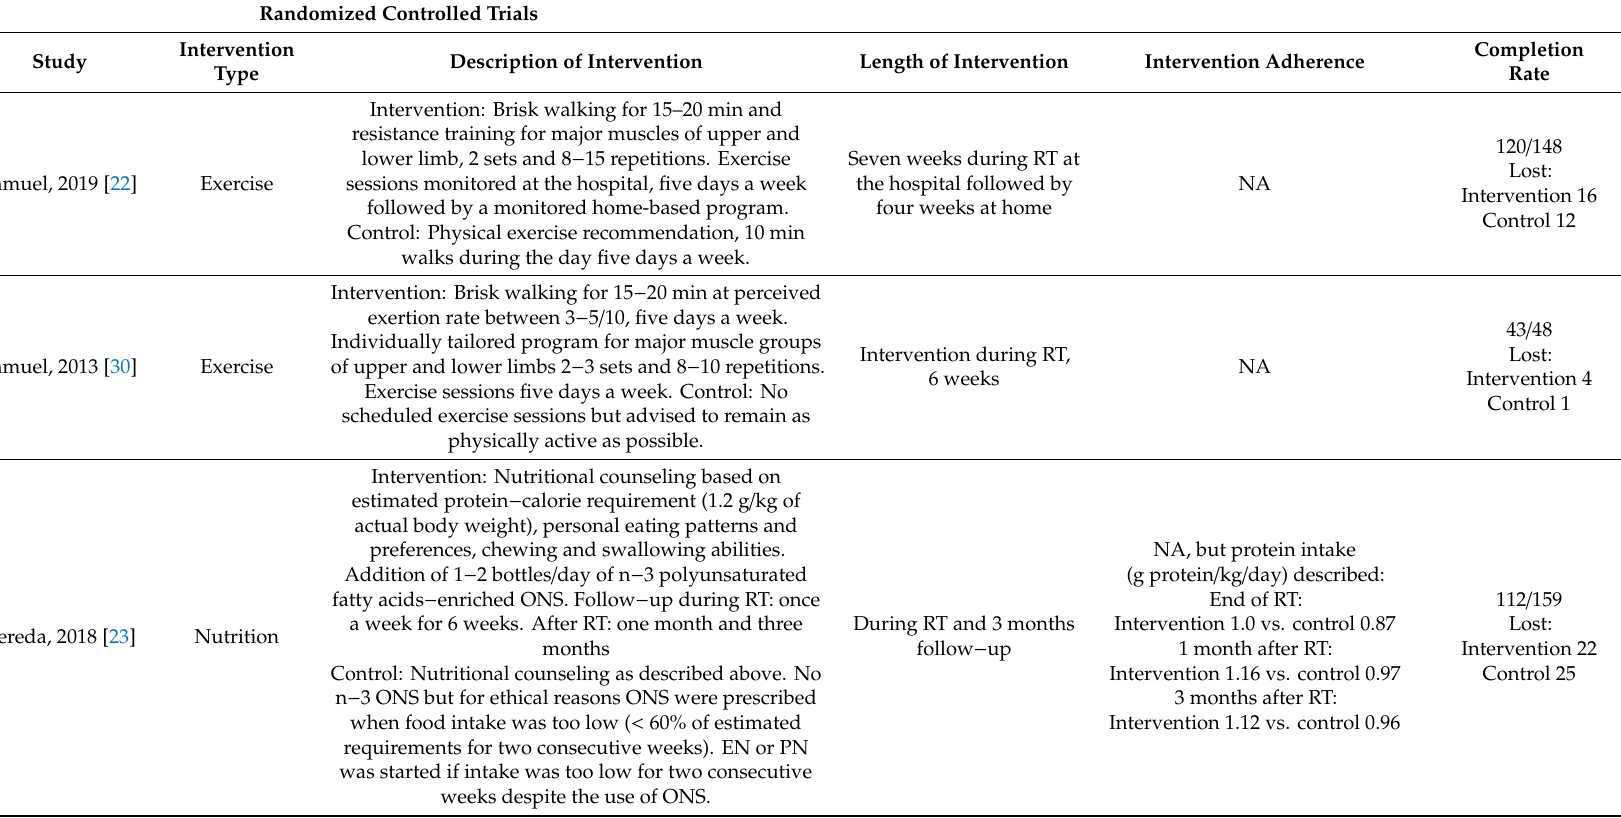
Table 4. Description of intervention, length of follow-up, adherence to intervention and completion rate, organized according to design, year of publication and